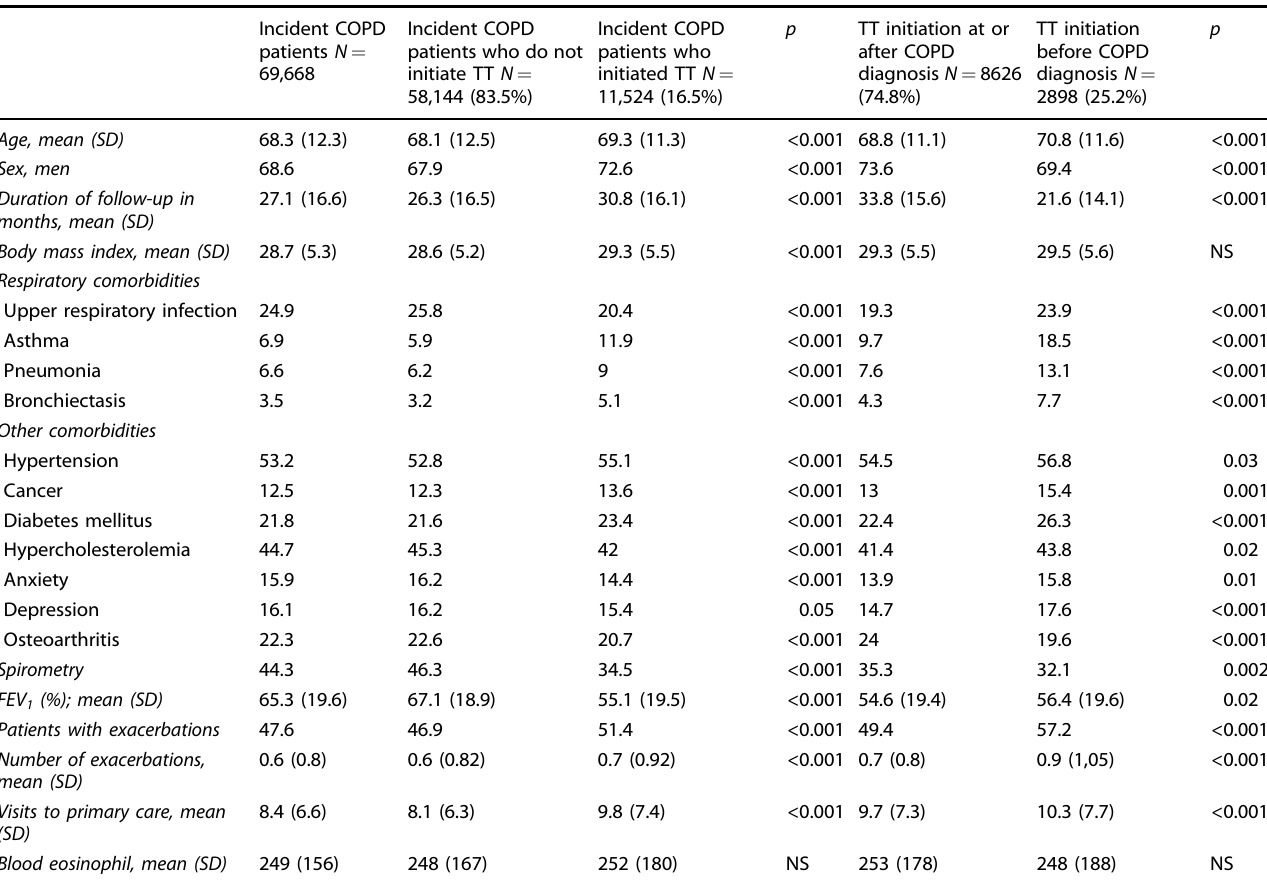
Table 1. Clinical characteristics of incident COPD patients and subgroups according to TT initiation and period of